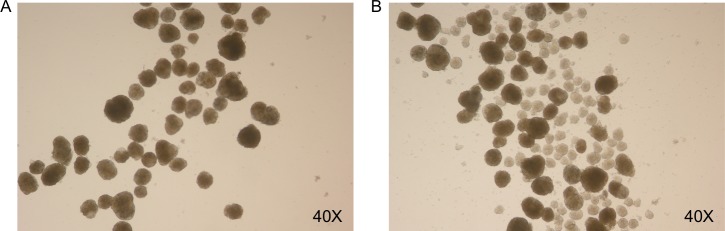
Islets and islets + DPS preparations.Representative image of 100 islets cultured alone (A) or with 200 DPS (B). Magnification 40X.